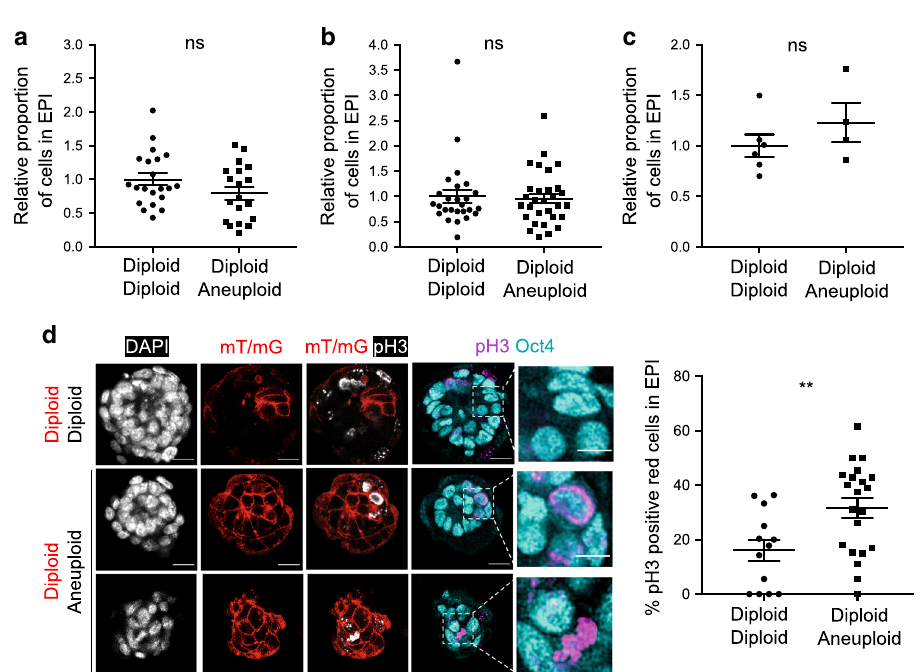
Fig. 3 Size regulation of diploid – aneuploid epiblasts during peri-implantation development. Embryos were treated with reversine (or DMSO) at the four- to eight-cell stage transition. a Eight-cell diploid – aneuploid and diploid – diploid chimeras were generated at the eight-cell stage. Immunosurgery was performed at the late blastocyst stage to isolate the ICM from the TE. The ICMs were embedded in Matrigel and cultured in IVC medium for 72 h. n = 19 diploid – aneuploid; n = 1900 EPI cells and n = 21 diploid – diploid chimeras; n = 2636 EPI cells. Student ’ s t test. b Sixteen-cell diploid – aneuploid and diploid – diploid chimeras were generated at the eight-cell stage. Immunosurgery was performed on the double size chimeras and ICMs were cultured in IVC medium for 72 h as above. Diploid – diploid n = 26 chimeras; n = 1772 EPI cells and diploid – aneuploid n = 30 chimeras; n = 1961 EPI cells. Mann – Whitney test. c Eight-cell diploid – aneuploid and diploid – diploid chimeras were transferred to pseudo-pregnant mothers and recovered 12 h after implantation and then in vitro cultured for 36 h. n = 4 diploid – aneuploid; n = 604 EPI cells and n = 6 diploid – diploid chimeras; n = 737 EPI cells. Mann – Whitney test. For graphs a – c , relative number of cells in the EPI were analysed for both types of chimeras (relative to the average of diploid – diploid chimeras) at the end of the peri-implantation culture to investigate the level of size regulation of diploid – aneuploids with respect to diploid – diploids. ns = not signi fi cantly different. d Eight-cell diploid (red) – aneuploid and diploid (red) – diploid chimeras were generated. Immunosurgery was performed and ICMs were cultured as above for 48 h. The percentage of the number of pH3-positive red fl uorescent EPI cells of the total red fl uorescent EPI cells was analysed for each chimera, for both diploid – diploid and diploid – aneuploid ICMs. n = 21 diploid – aneuploid; n = 546 red EPI cells and n = 13 diploid – diploid chimeras; n = 217 red EPI cells. Scale bars, 20 μ m. Squares indicate magni fi ed regions. Scale bars, 10 μ m. Student ’ s t test and ** p = 0.0084. For all the graphs, all data are mean ± s.e.m. Source data are provided as a Source Data fi